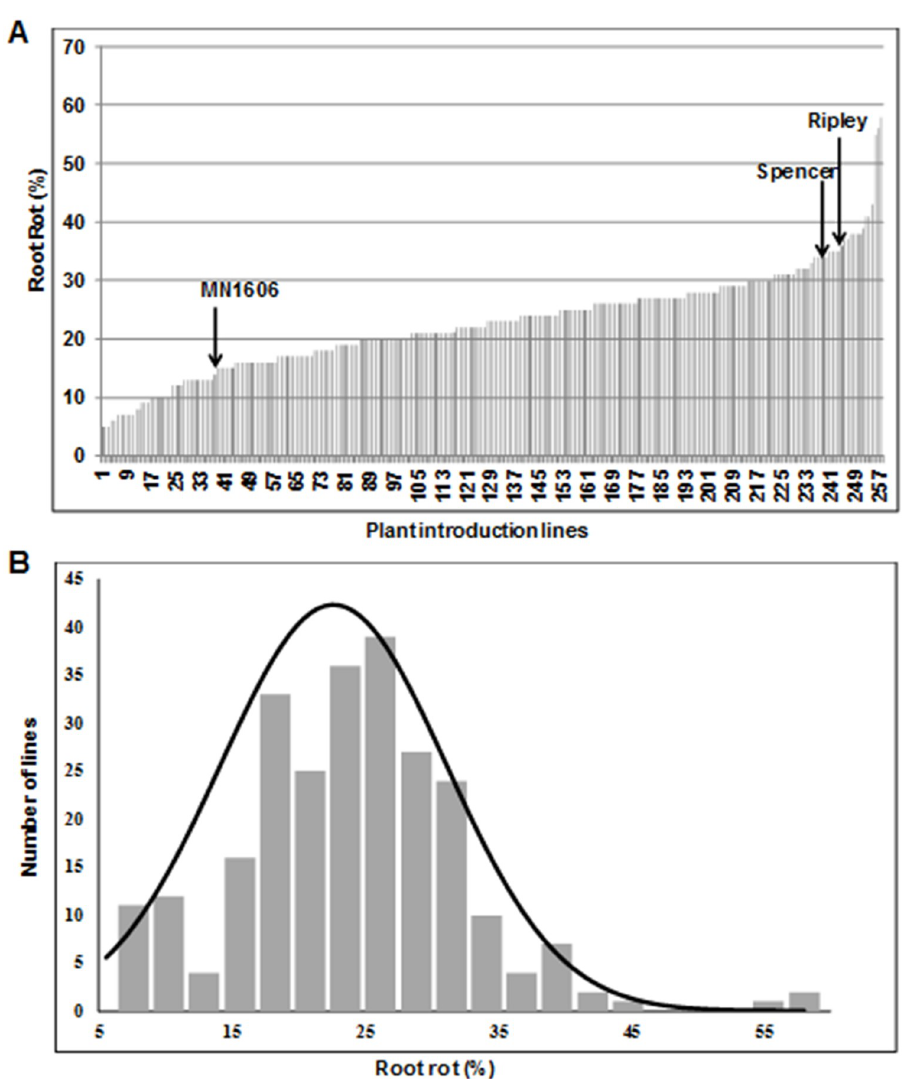
Fig 2. Root responses of 254 PI lines to F . virguliforme . (A) The root rot symptoms were scored 37 days following infection with F . virguliforme . Arrows indicate the disease scores of the SDS resistant cultivars, MN1606 and Ripley, and susceptible cultivar, Spencer. Phenotypic evaluation was conducted five times, each with three replications. The values are means of fifteen biological replications. (B) Distribution of root rot symptoms among the 254 PI lines that are presented in